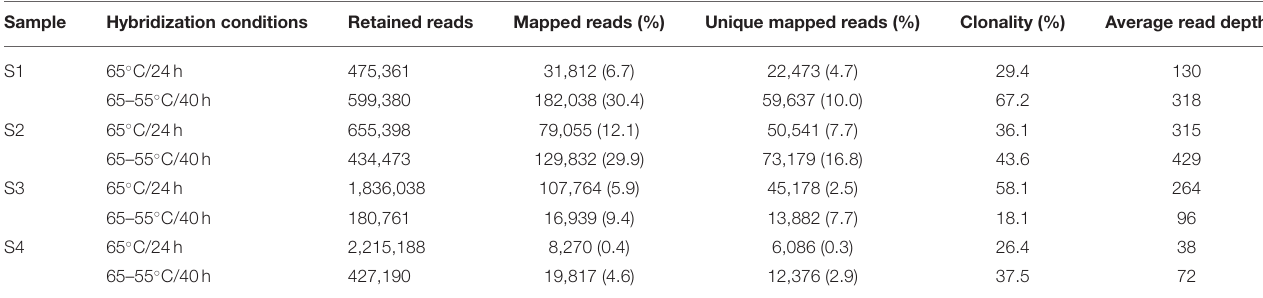
TABLE 1 | Number of retained reads, mapped reads, unique mapped reads, clonality, and average read depth for four degraded human bone samples for two different hybridization enrichment